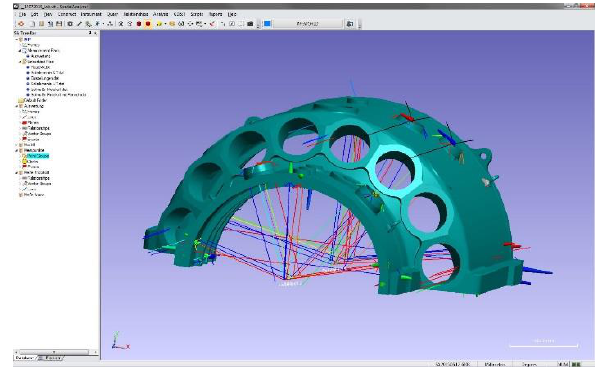
Figure 24: Exemplary analysis in SpatialAnalyzer (Image: Siemens)